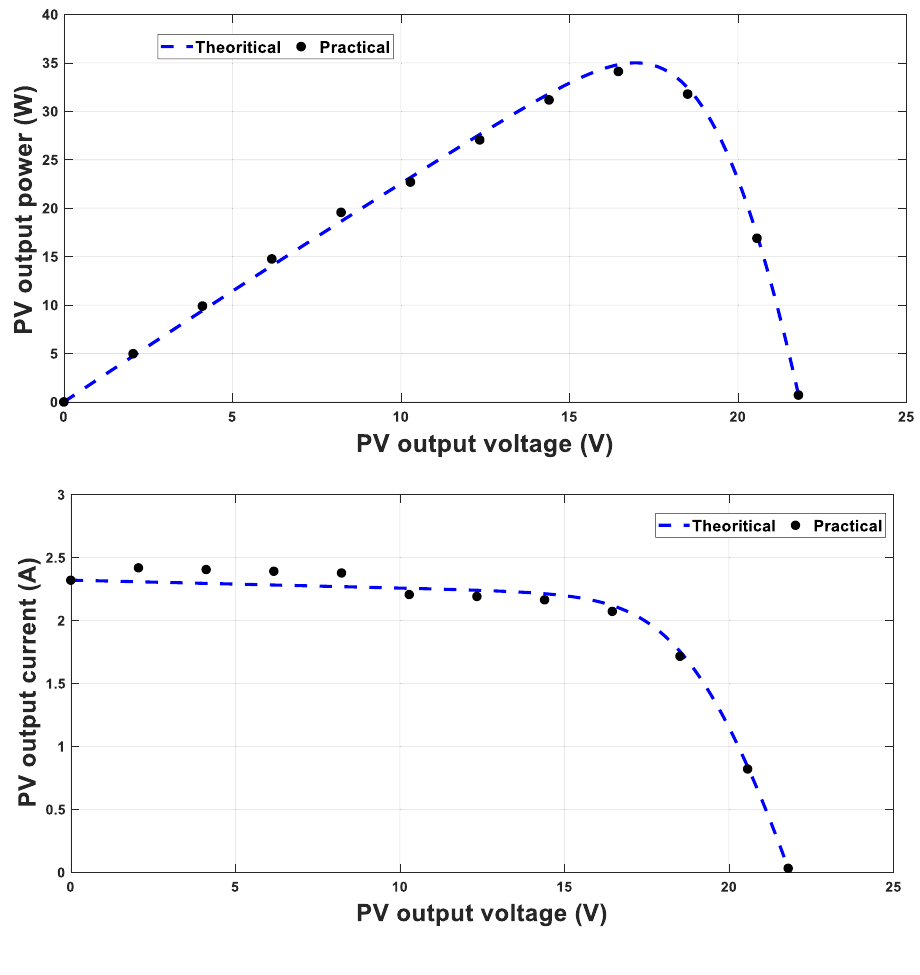
Figure 9. Experimental verification of solar cell characteristics.